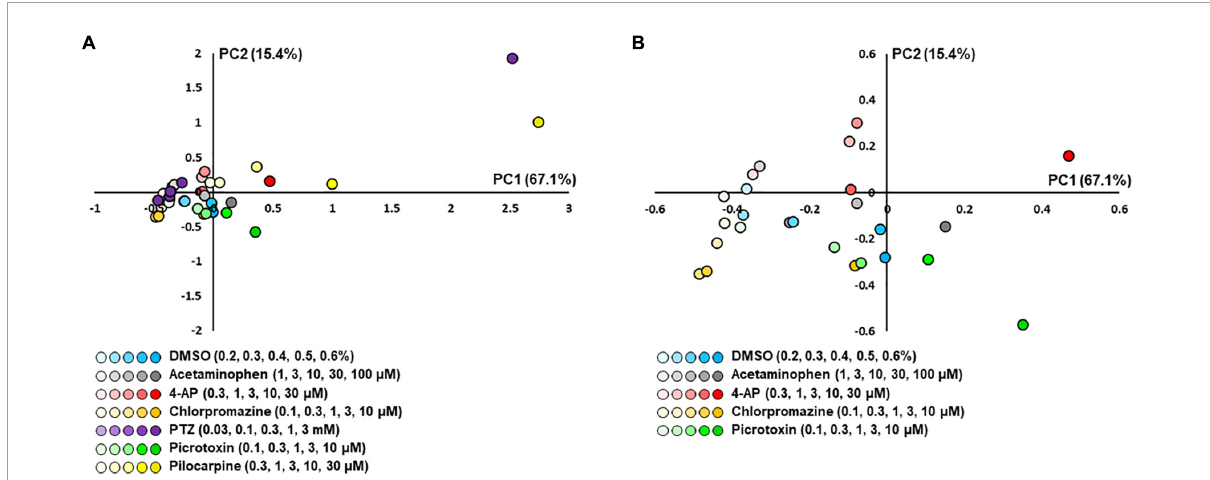
FIGURE7 Scatterplots of PCA using the effective parameter set for detecting the drug responses of iPSC-derived astrocytes. (A) DMSO ( n = 6, blue), acetaminophen ( n = 6, gray), 4-AP ( n = 6, red), chlorpromazine ( n = 6, orange), PTZ ( n = 6, purple), picrotoxin ( n = 6, green), and pilocarpine ( n = 6, yellow). Higher concentrations are indicated by darker colored symbols. (B) The magnified scatterplots excluding the plots of pilocarpine and